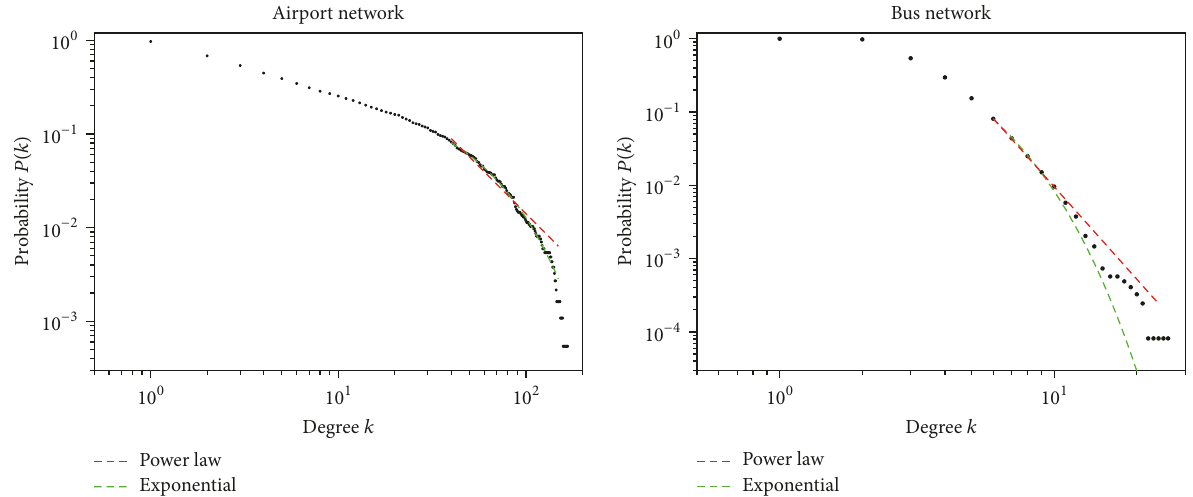
Figure 1: Example of seemly scale-free networks. The left and right panels, respectively, depict the cumulative degree distribution of the airport and the bus networks, as described in Appendix. Red and green dashed lines further depict the best power law and exponential fits of the two